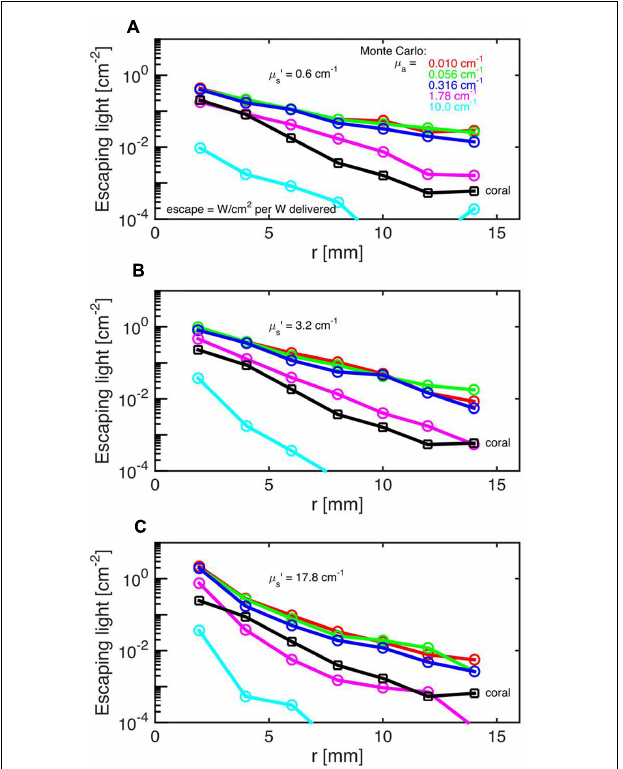
FIGURE 3 | Monte Carlo simulations to estimate coral tissue optical properties. Escaping light ( φ ) as a function of radial distance (r) from the incident laser light beam as measured over the intact coral tissue surface. Monte Carlo simulations were run for 5 µ a values, assuming µ s ’ = 0.6 (A) , 3.2 (B) , and 17.8 cm − 1 (C) . The experimental data are black squares (mean ± SD, n = 13 repetitions). The match between experiment and simulation was based on both the slope and absolute values of the φ (r) curves. The best choice was µ a = 1.8 cm − 1 and µ s ’ = 10 cm − 1 .